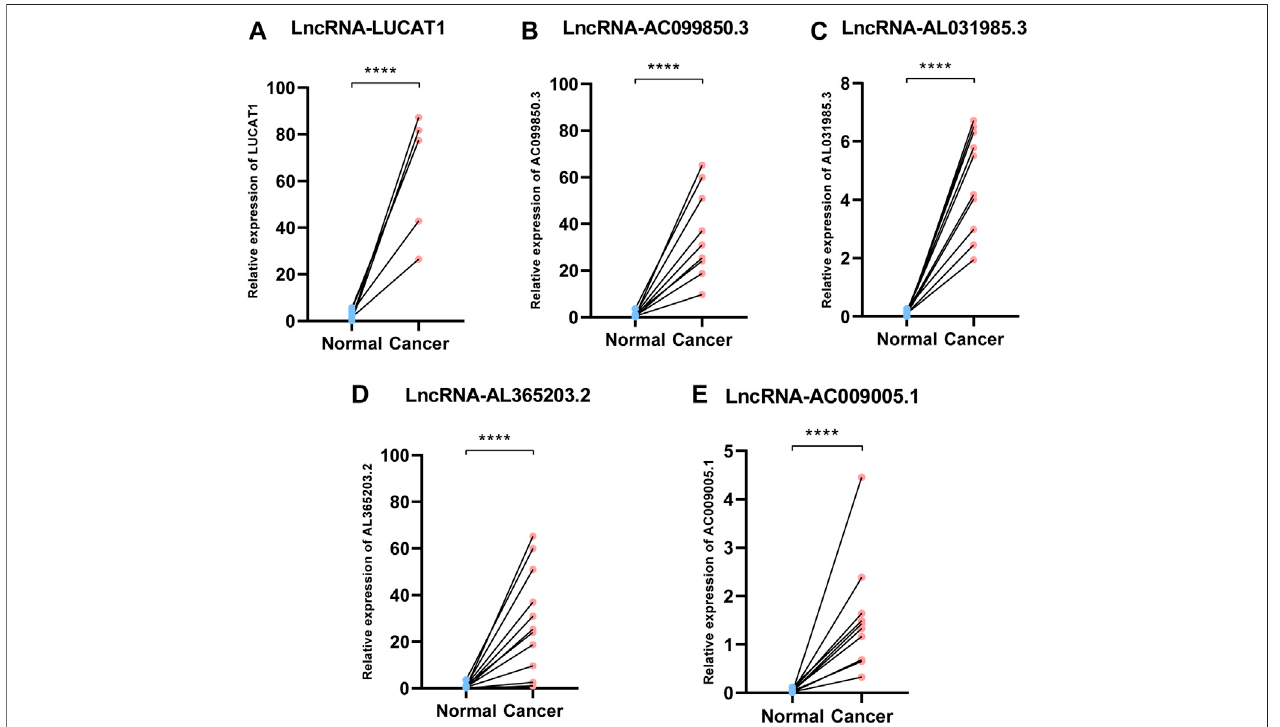
FIGURE 7 | Expression of ferroptosis-related lncRNAs in HCC patients. Relative of RNA expression of fi ve ferroptosis-related lncRNAs between cancerous and adjacent normal tissues. (A) LUCAT1 (B) AC099850.3 (C) AL031985.3 (D) AL365203.2 (E) AC009005.1. ****means p < 0.0001; HCC: hepatocellular carcinoma.